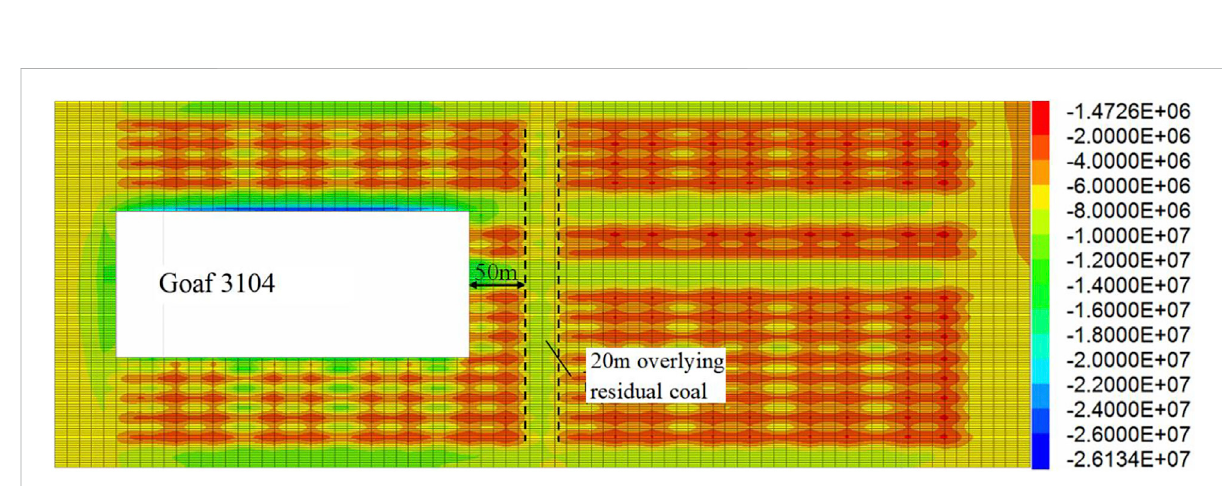
FIGURE 20 Cloud diagram of vertical stress distribution at 50m of overlying residual coal pillar